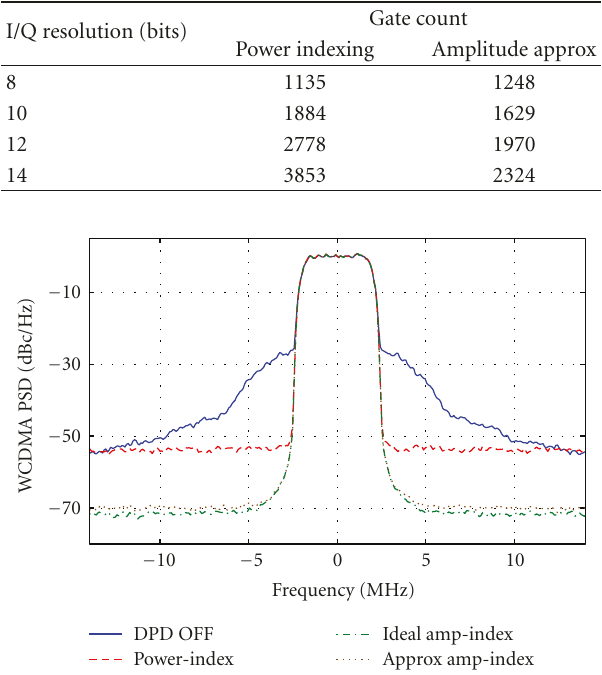
Figure 4: PSD performances of an LUT predistorter using ideal amplitude indexing, amplitude indexing with approximation, or power indexing. Input signal is